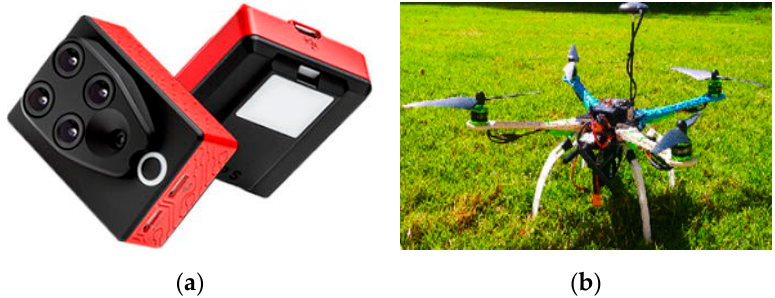
Figure 6. Examples of multispectral sensors for monitoring crop data [50]: ( a ) a multispectral sensor for crop discrimination and ( b ) an airborne multispectral sensor for assessing nitrogen nutrition [51].